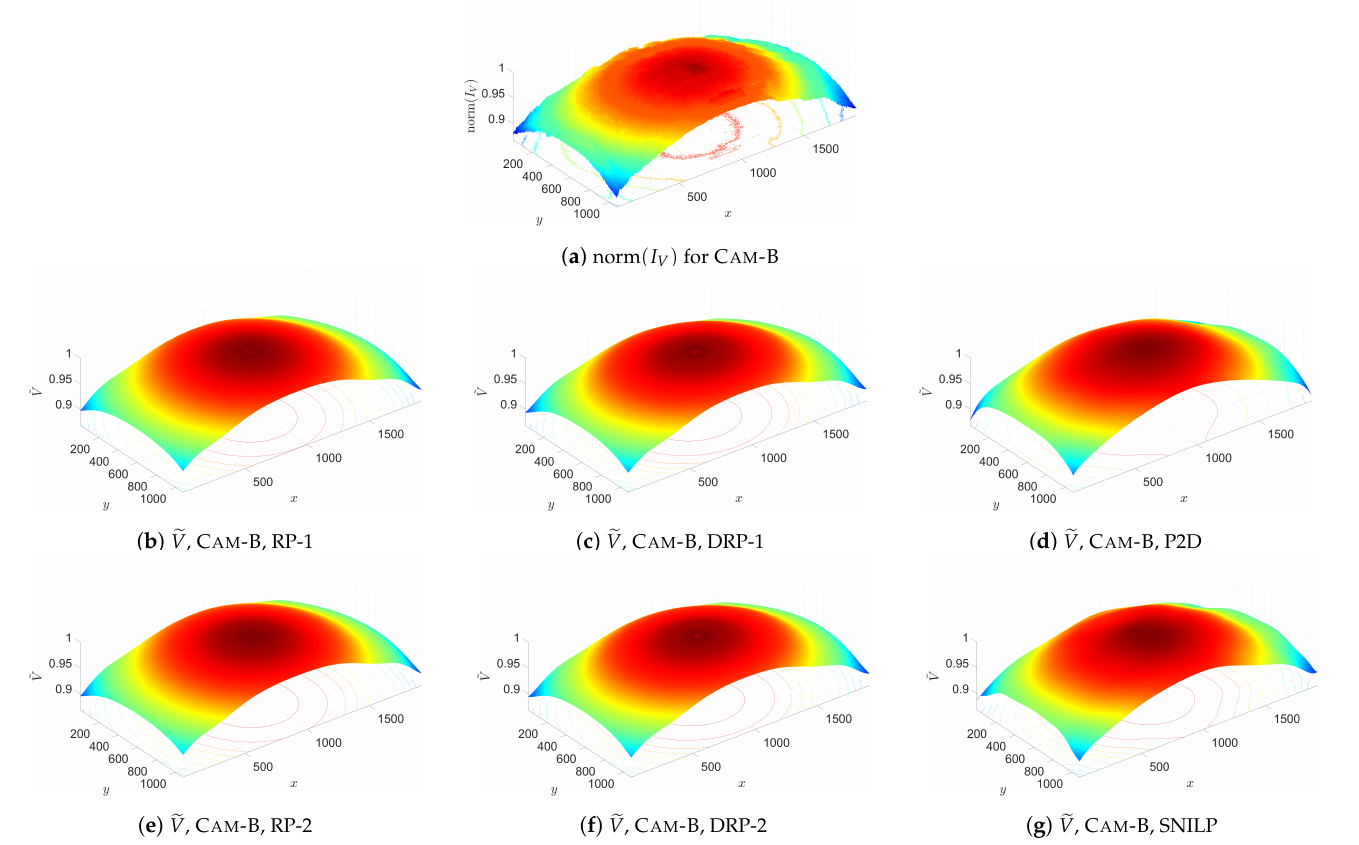
Figure A3. Comparison of vignetting image I V and vignetting estimates (cid:101) V obtained for the tested models and C AM -B.